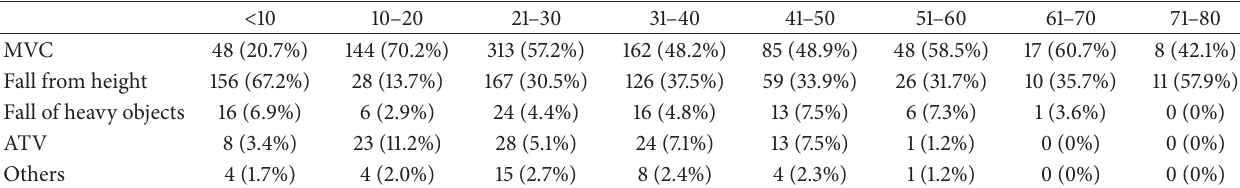
Figure 2: Traumatic brain injury in different age groups based on head abbreviated injury severity (AIS) and Glasgow Coma Scale (GCS). Table 3: Mechanism of injury by age groups.